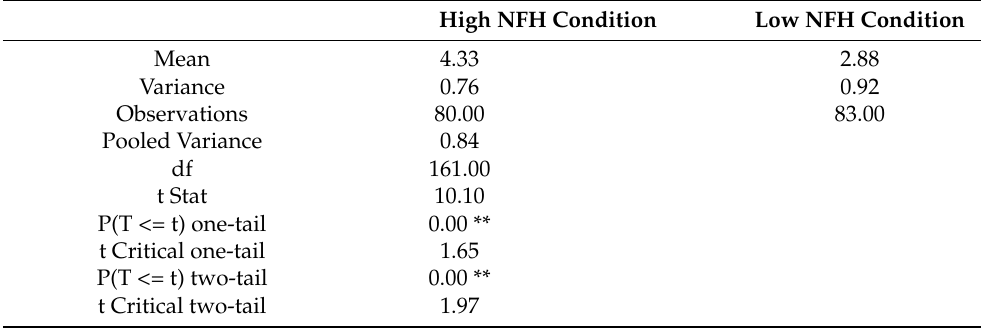
Table 8. Study 2a Independent Sample t